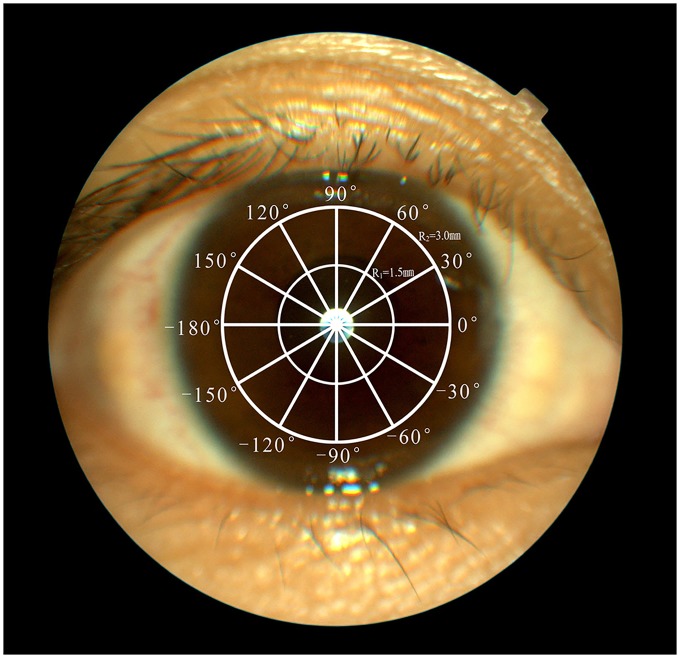
Optical coherence tomography scan pattern.Six meridians (0°, 30°, 60°, 90°, 120°, and 150°) were selected to measure the thickness of the whole cornea flap. The five measurement points on each meridian were ±0.5 mm, ±1.5 mm, and ±3.0 mm from the center. “+” denotes superior side, and “-” denotes inferior side.